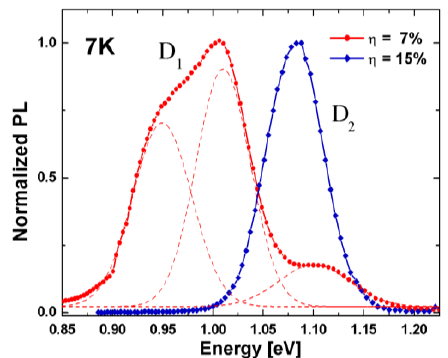
Figure 3. Low-temperature photoluminescence spectra of two PED-grown CIGS samples. Sample D 1 was deposited at a substrate temperature of 500 °C, sample D 2 at 270 °C (LTPED).